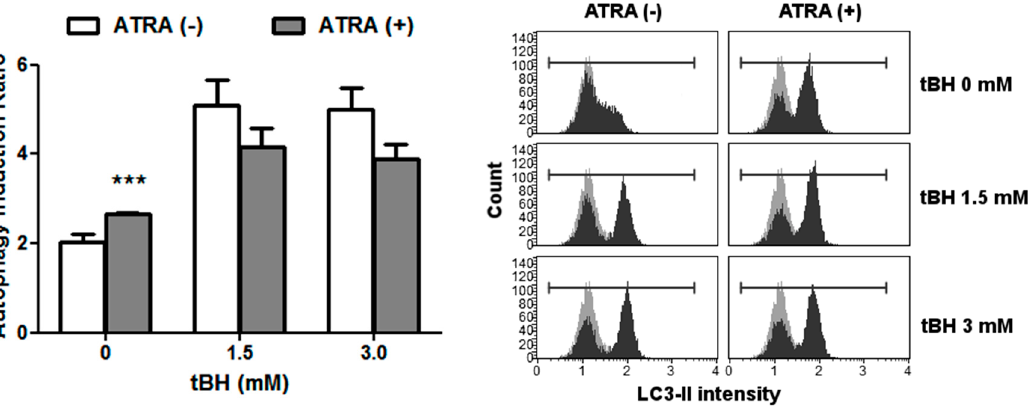
Figure 4. Autophagy of ATRA-treated and control ARPE-19 cells exposed to tert -butyl hydroperoxide (tBH) for 4 h at 37 °C as assessed by flow cytometry analysis of LC3-II staining. Results are presented as mean ± SEM, n = 8, *** p < 0.001. Representative FACS analysis of LC3-II labeling profiles are presented.